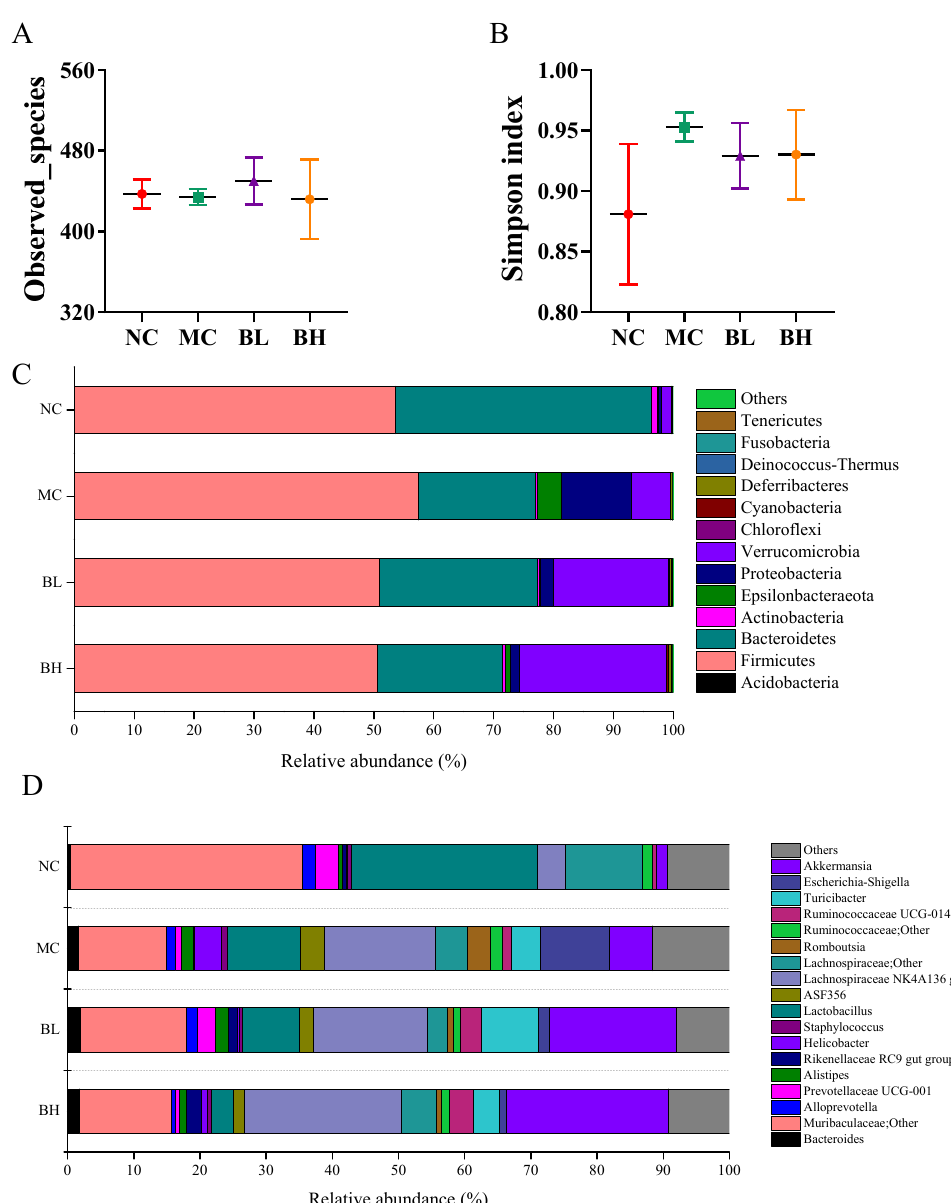
Figure 6. Effects of B. lactis XLTG11 on structure and composition of gut microbiota. ( A ) Observed_species; ( B ) Simpson index; ( C ) Gut microbiota composition at the phylum level; ( D ) Gut microbiota composition at the genus level. NC, normal control group; MC, model control group; BL, low-dose B. lactis XLTG11; BH, high-dose B. lactis XLTG11.